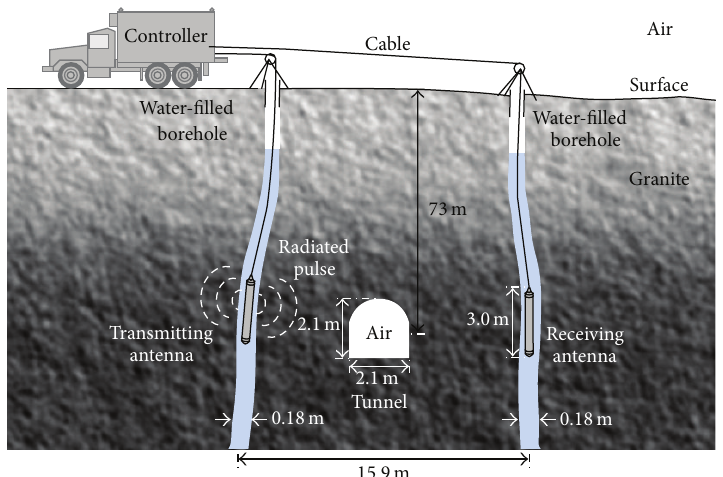
Figure 1: Experimental configuration of cross-borehole pulse radar in a well-suited tunnel test site in